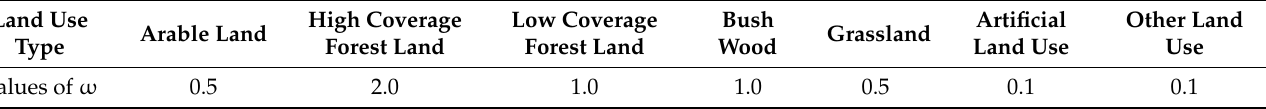
Table 3. The referencing values of parameter ω for evaluating the importance of water